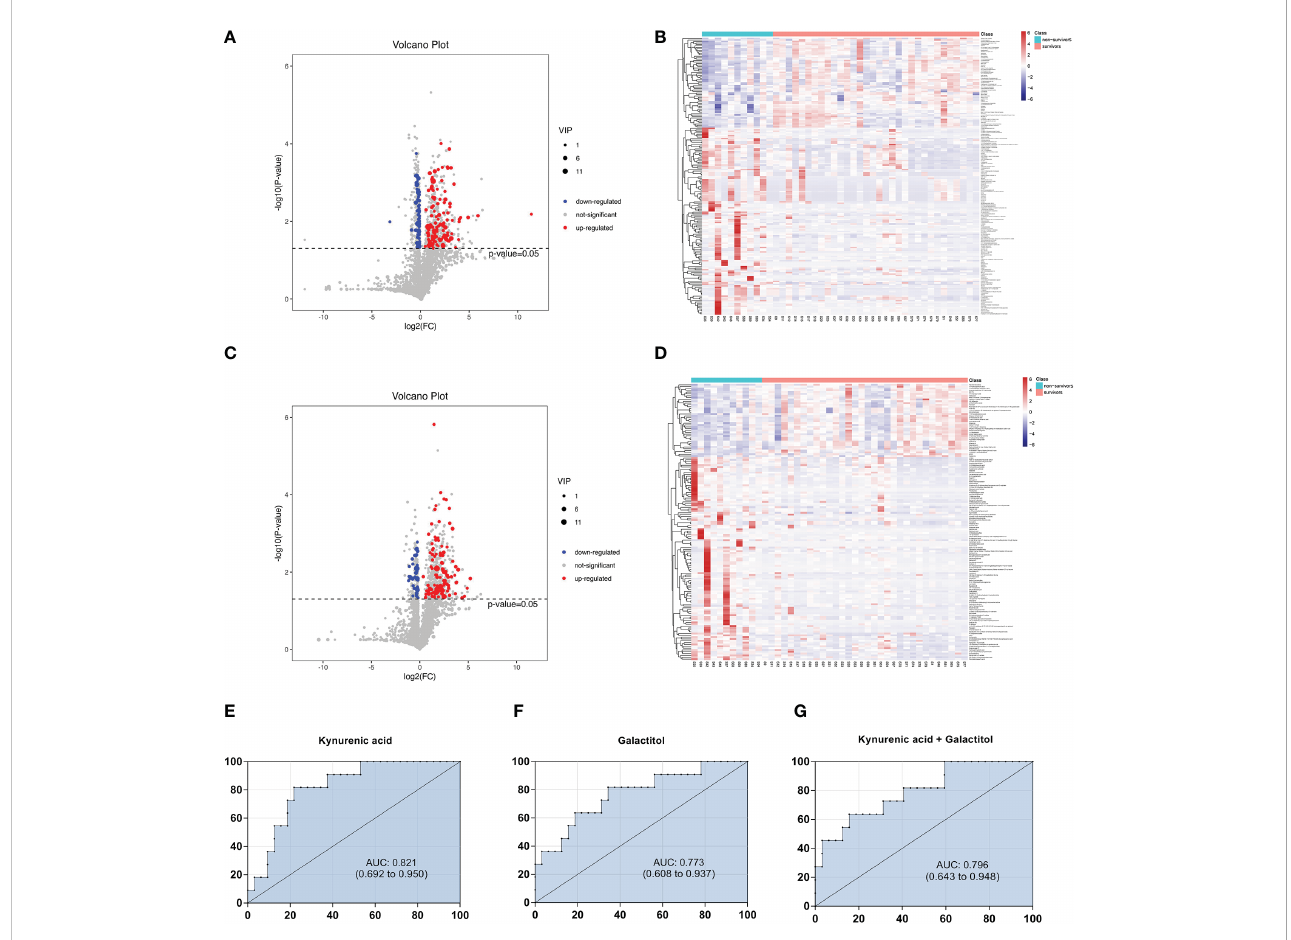
FIGURE 6 Volcano diagrams and heatmaps between survivors and non-surviviors of cardiac dysfunction group. (A) Volcano map in positive ionization mode. (B) Heatmap in positive ionization mode. (C) Volcano map in negative ionization mode. (D) Heatmap in negative ionization mode. (E – G) ROC curve analysis of the ability of differential metabolites to predict 28-mortality in sepsis with cardiac